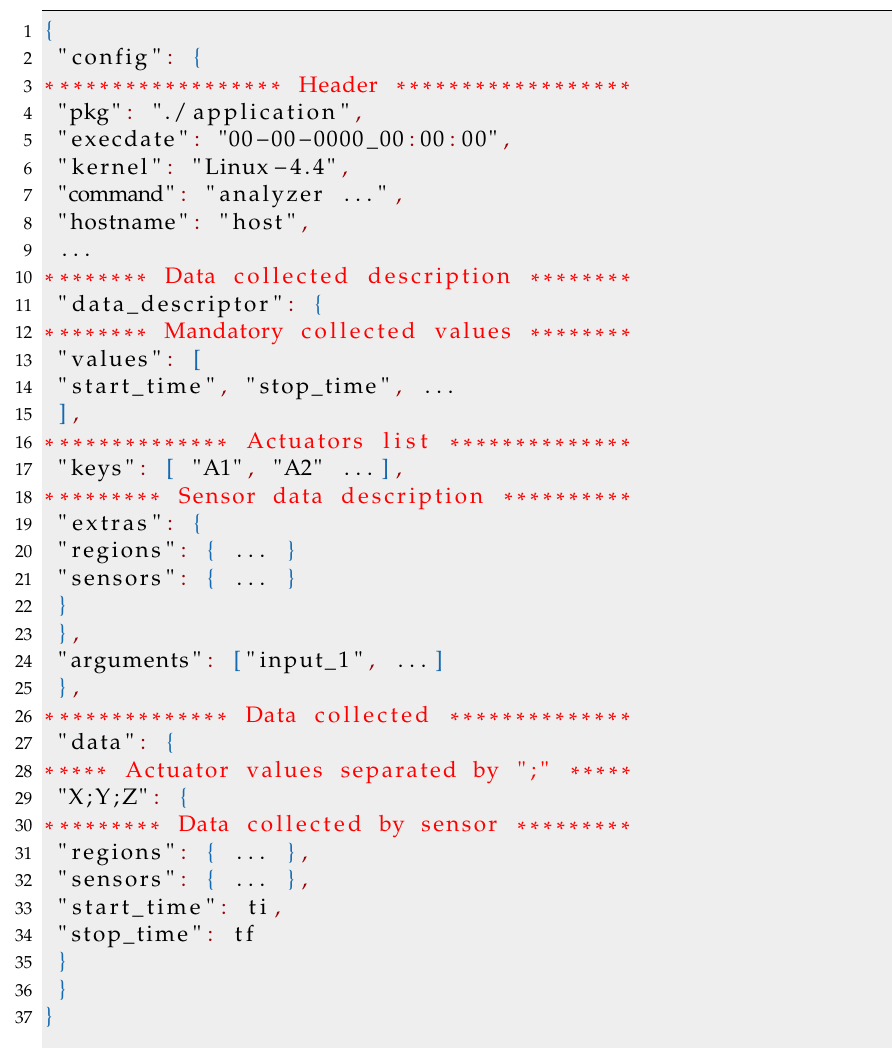
Listing 3. Sample of exported data file showing the internal structure and organization of the